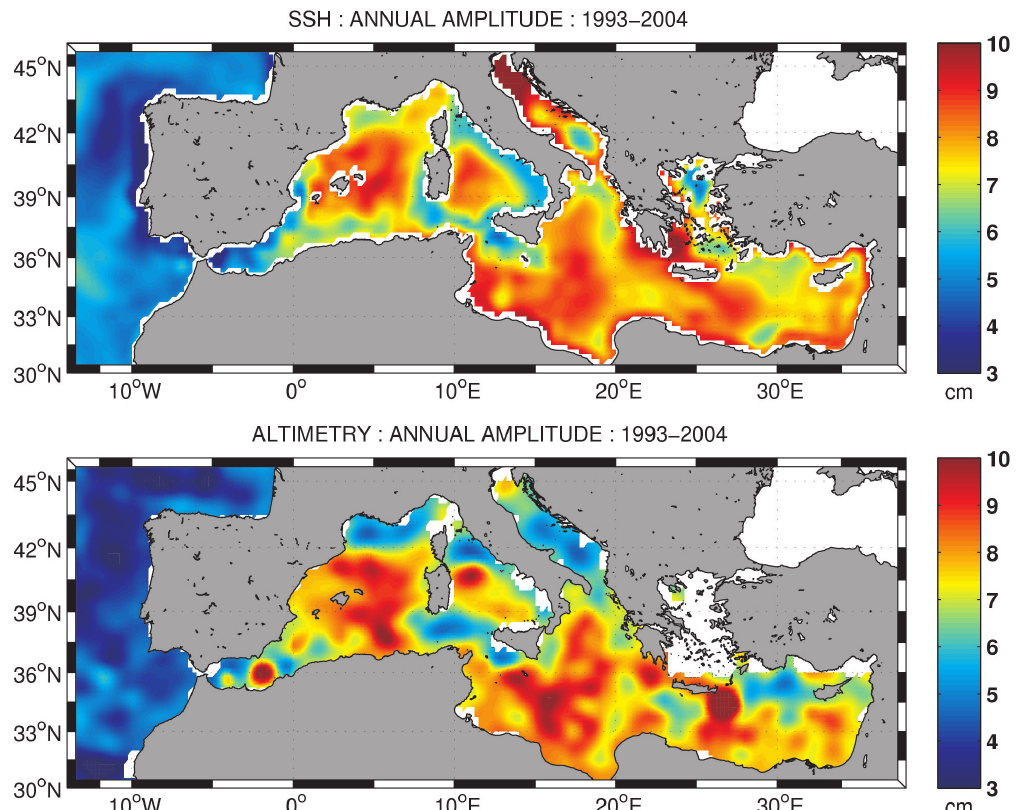
Fig . 9. – ORCA SSH and altimetry annual amplitude maps for